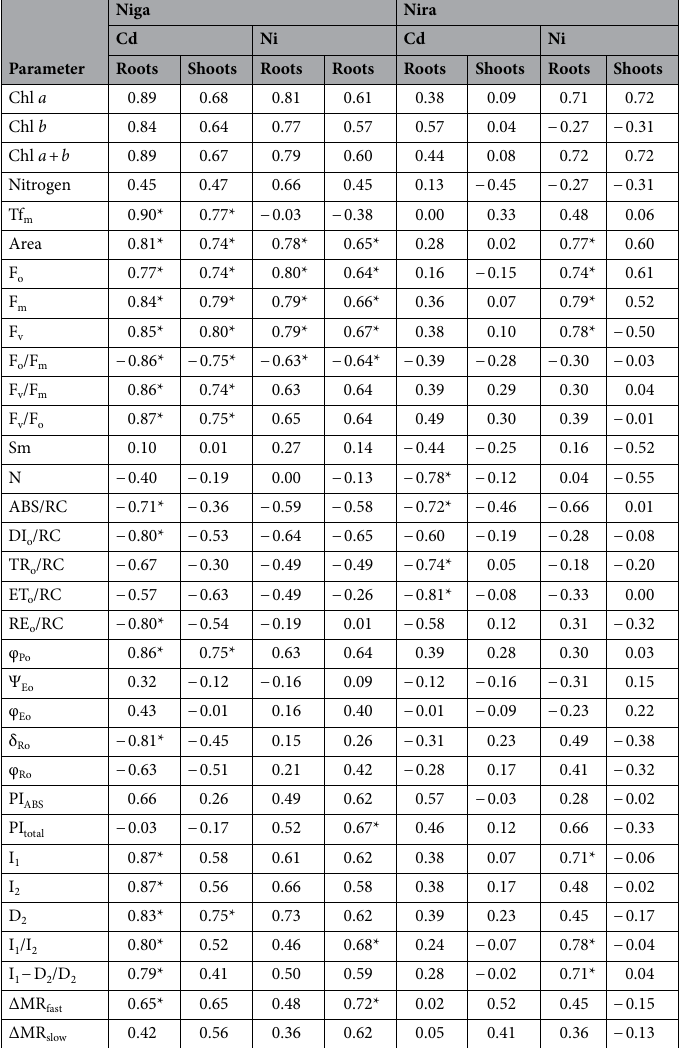
Table 5. Correlation coefficients (r) between photosynthetic efficiency parameters obtained from prompt (JIP- test), delayed fluorescence (I 1 ; I 2 ; D 2 ; I 1 /I 2 ; (I 1 − D 2 /D 2 )), and phases of reflection intensity (ΔMR fast ; ΔMR slow ) and root and shoot length (correlations significant at p < 0.05, n =